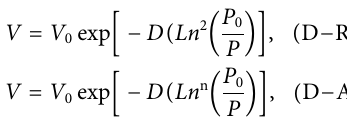
Frontiers in Earth Science |